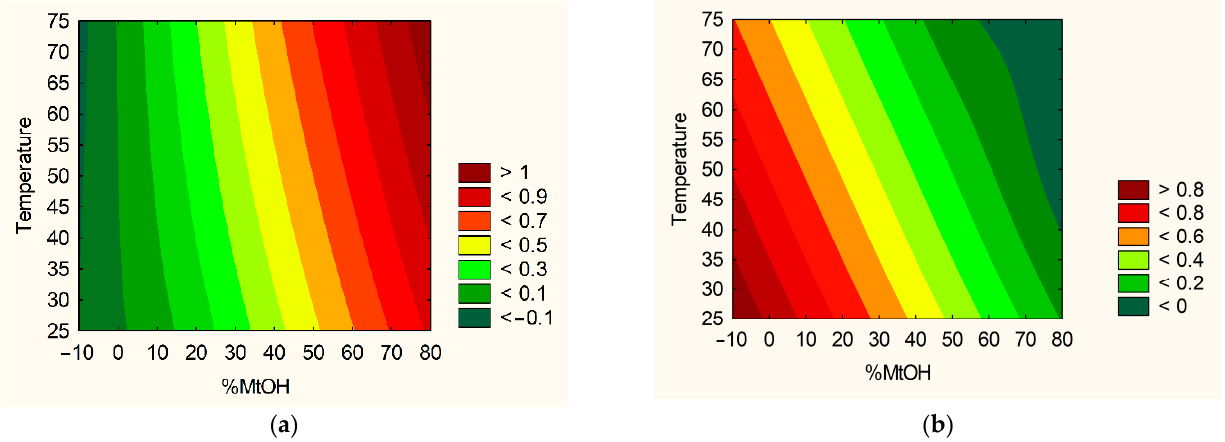
Figure 2. Model utility contour profiles for effect with a positive sign ( a ) and negative sign ( b ) for extract optimalization.